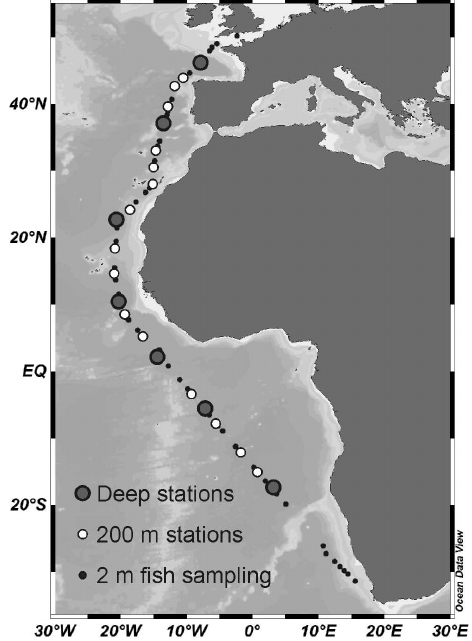
Fig. 1. Map of the sampling locations on the cruise ANT-XXV/1 of RV